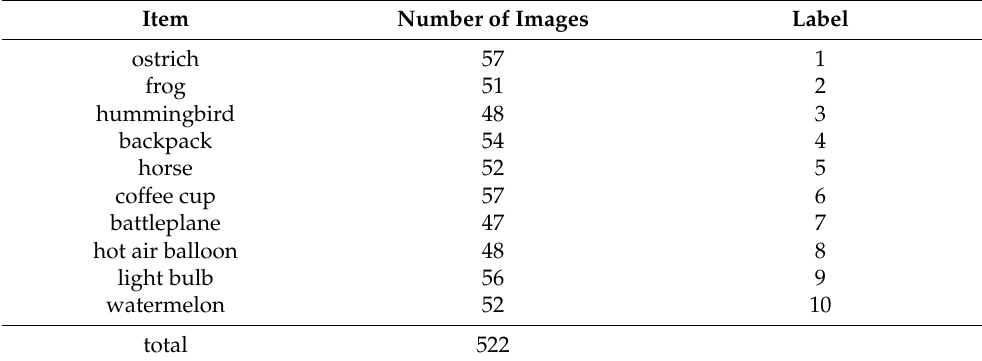
Table 1. The number of images in each